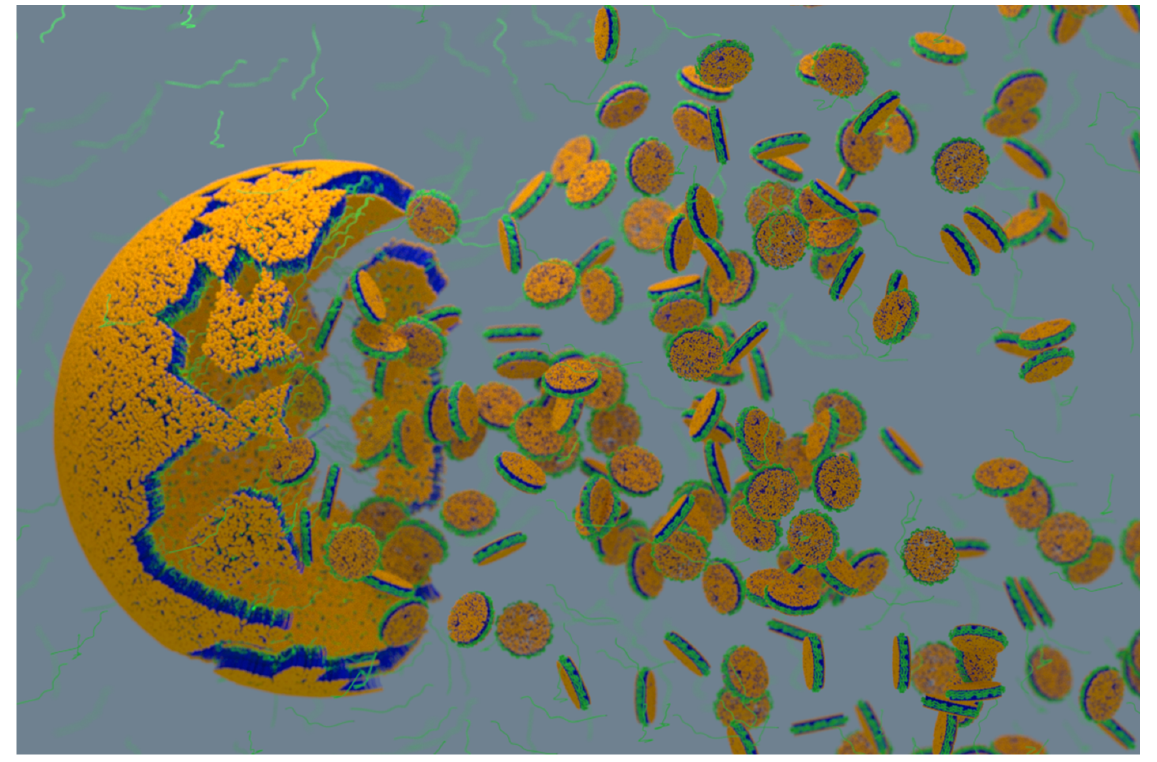
Figure 6. Schematic showing the formation of polymer-nanodiscs upon mixing synthetic lipids/membranes (liposomes; yellow/blue) with an amphipathic polymer (green). Polymer dissolves lipid aggregates and self-assemble to form discoidal nano-size particles called “polymer-nanodiscs”. The size of the nanodisc depends on the lipid:polymer ratio. The time course of dissolution and nanodiscs formation depends on the type of polymer and lipids used. The stability of nanodiscs against temperature, divalent metal ions (such as Ca 2+ and Mg 2+ ), and pH also depend on the type of polymer and lipids used. This Figure and caption are adopted from reference [129] with copyright permission.